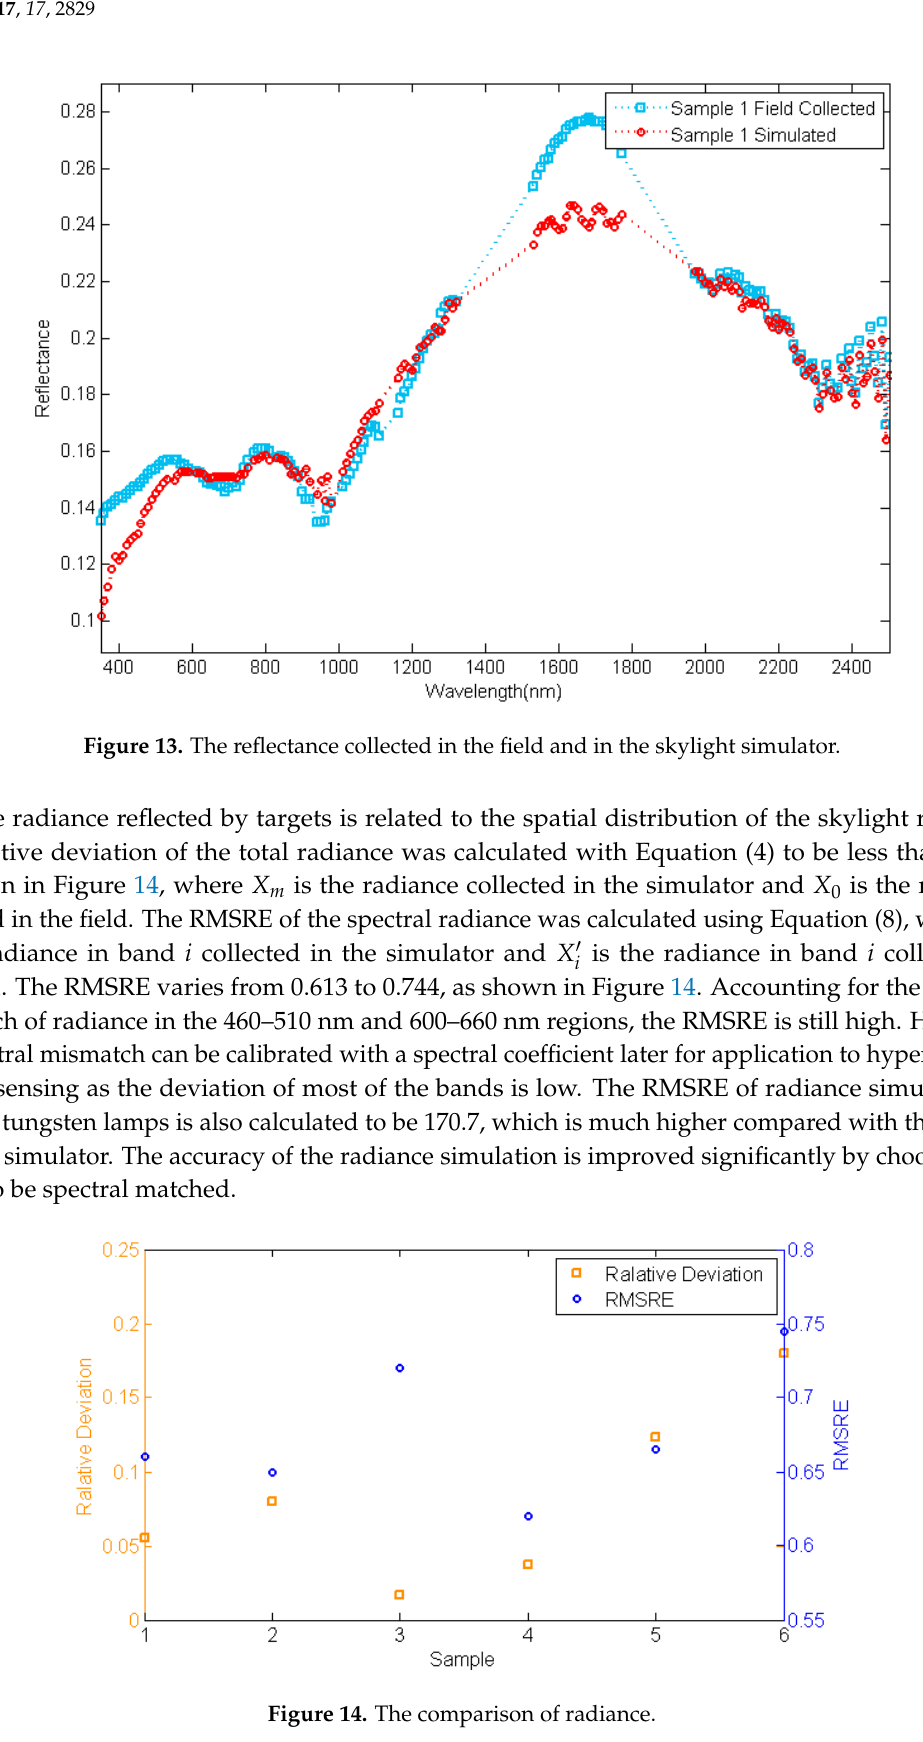
Figure 14. The comparison of radiance.